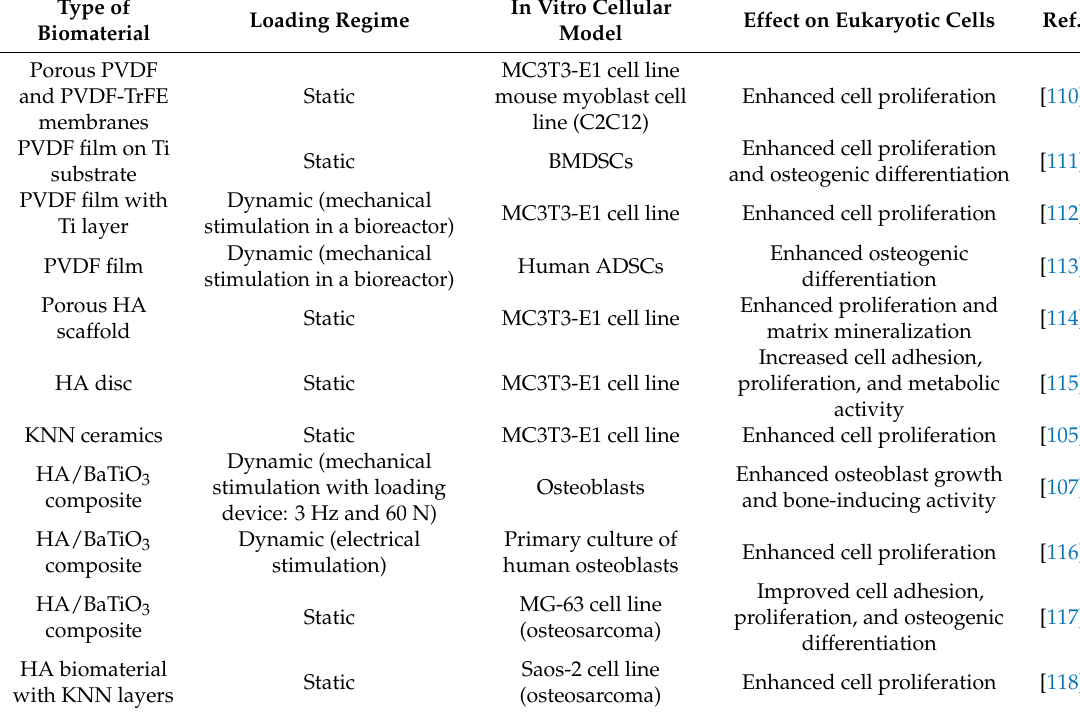
Table 3. Examples of piezoelectric biomaterials and their effect on eukaryotic